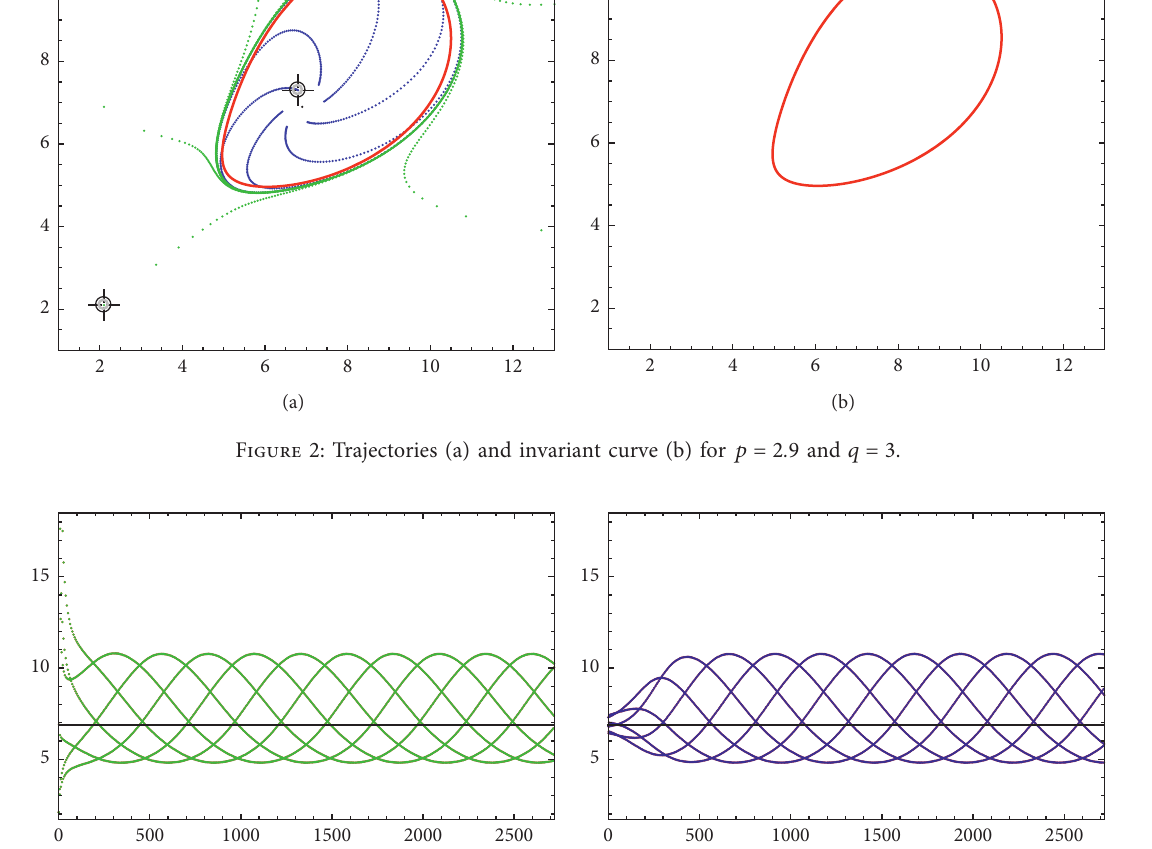
,x ) � ( 2 . 1 , 2 . 1 ) (a) and ( x − 1 0